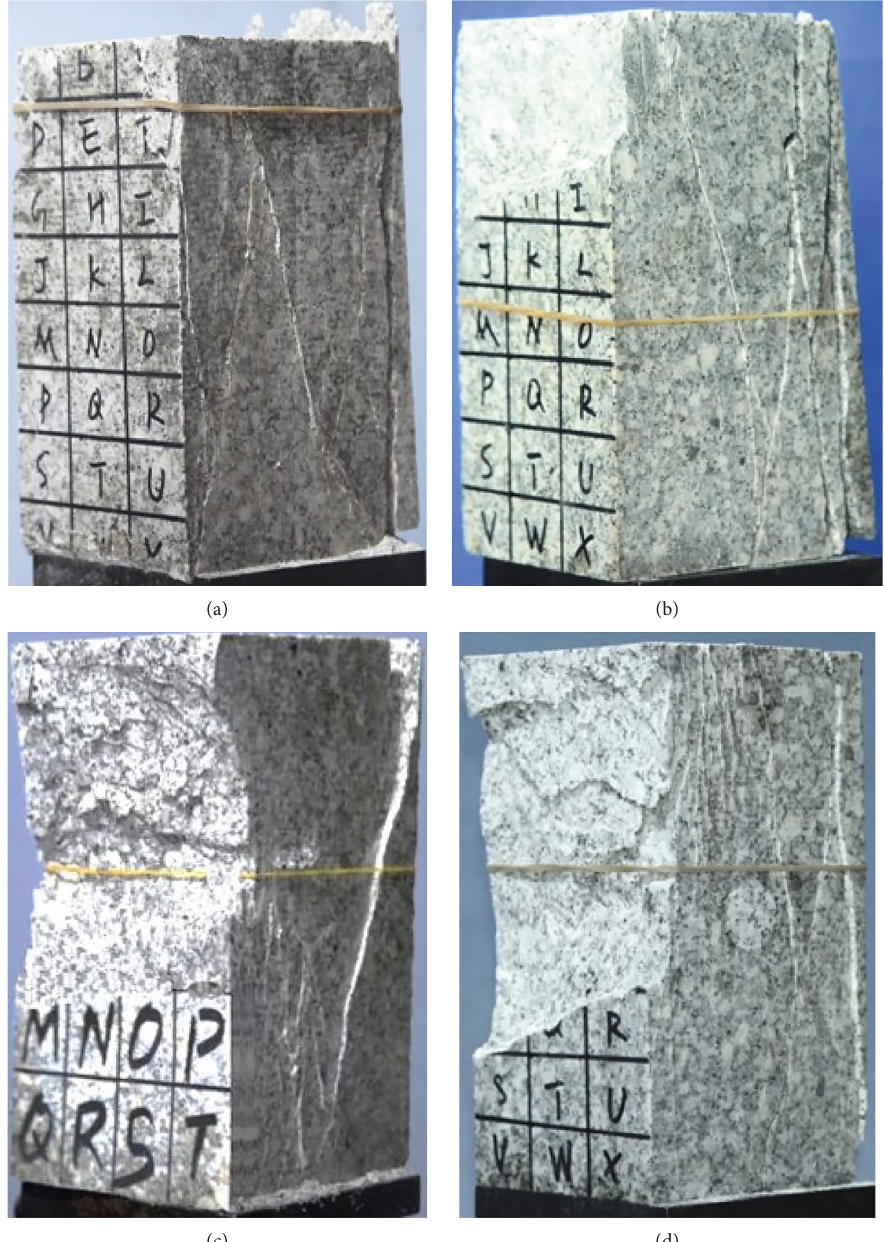
Figure 20: Failure form of the tested specimen under different support failure rates: (a) v � 0.1MPa/s; (b) v � 0.5MPa/s; (c) v � 1.0 MPa/s; (d) v � 2.0